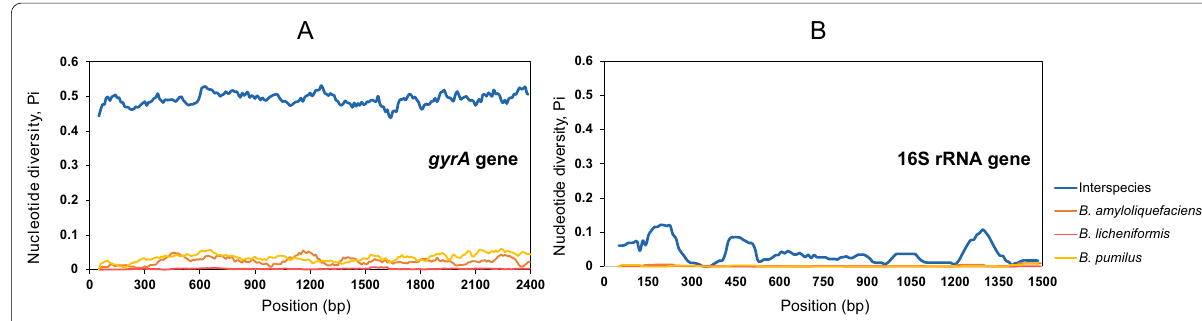
Fig. 1 Sliding window analysis of nucleotide variability [Pi (π)] along the sequence of the gyrA gene ( A) and 16S rRNA ( B) in Bacillus . 361 and 256 of gyrA and 16S sequences from 20 species and three species ( B. amyloliquefaciens (n aligned with the Kalign method and nucleotide diversity was determined in DnaSP (v.6) using a window size of 100‑bp, a step size of 10‑bp, and points based on the mid‑point of each window (i.e., the first point is at position 200). The blue lines display the Bacillus inter‑species nucleotide diversity of the two genes and the orange, red and yellow lines display the nucleotide diversity of two genes in B. amyloliquefaciens , B. licheniformis and B. pumilus, respectively. The sequence length of the gyrA gene for analysis was 2450 bp, and that of 16S rRNA was 1540